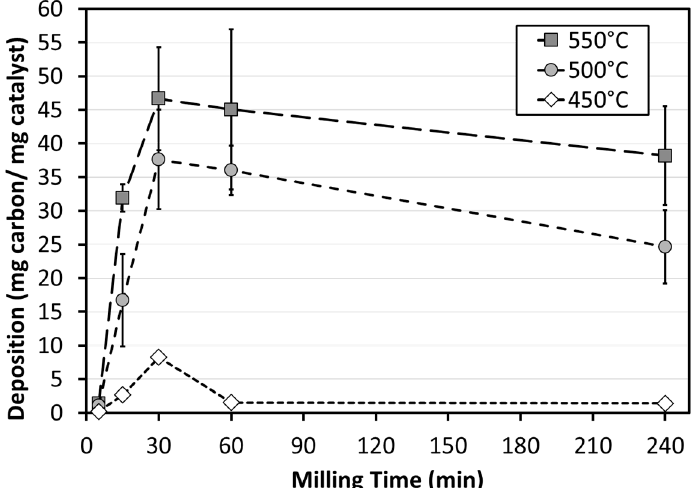
Figure 3. Normalized carbon deposition amounts from Pd-Co catalysts processed using varying milling times and reaction temperatures after a 1 h reaction duration in 1:4 C 2 H 4 :H 2 . All data points have error bars with a magnitude of one standard deviation from the mean.